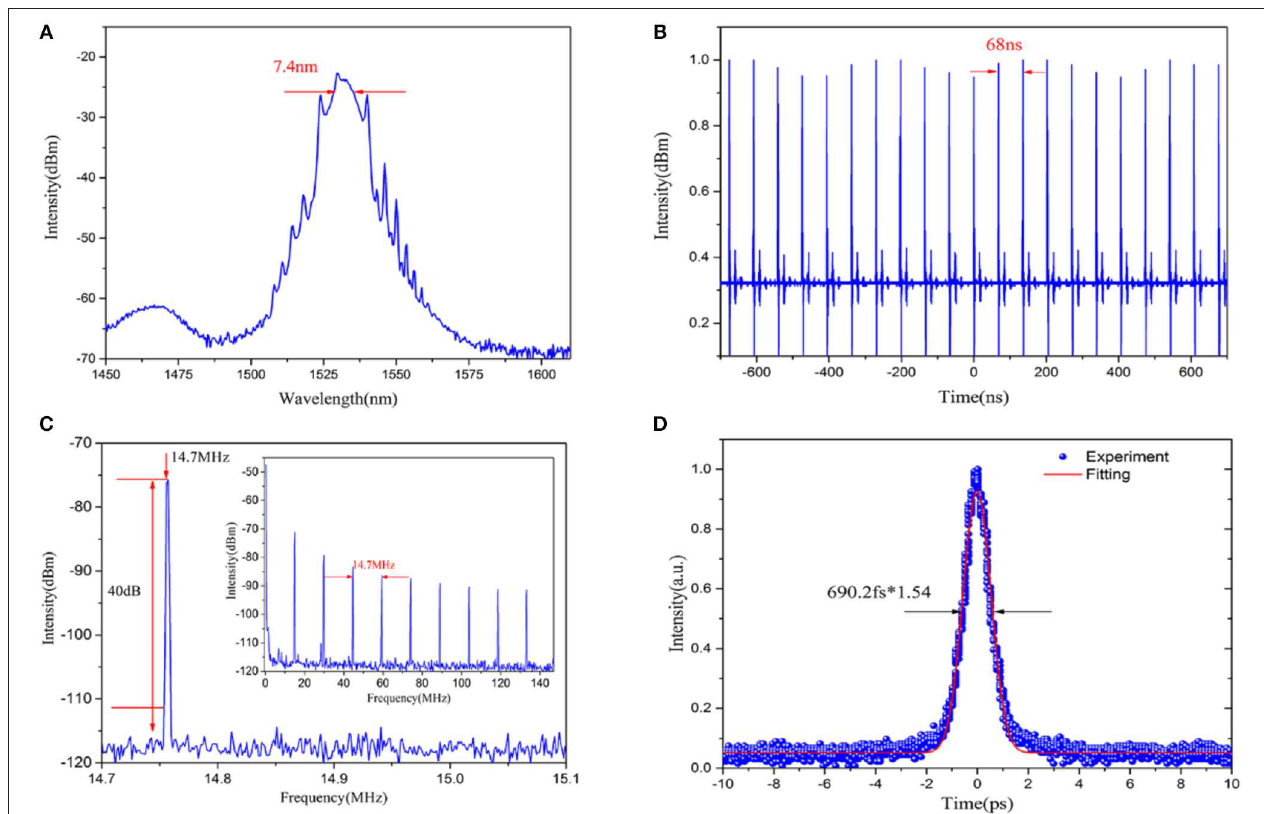
FIGURE 5 | Pulse output characteristics of hybrid mode-locked laser when the pump power is 135 mW. (A) output spectrum, (B) pulse trace on oscilloscope, (C) RF spectrum, (D) autocorrelation